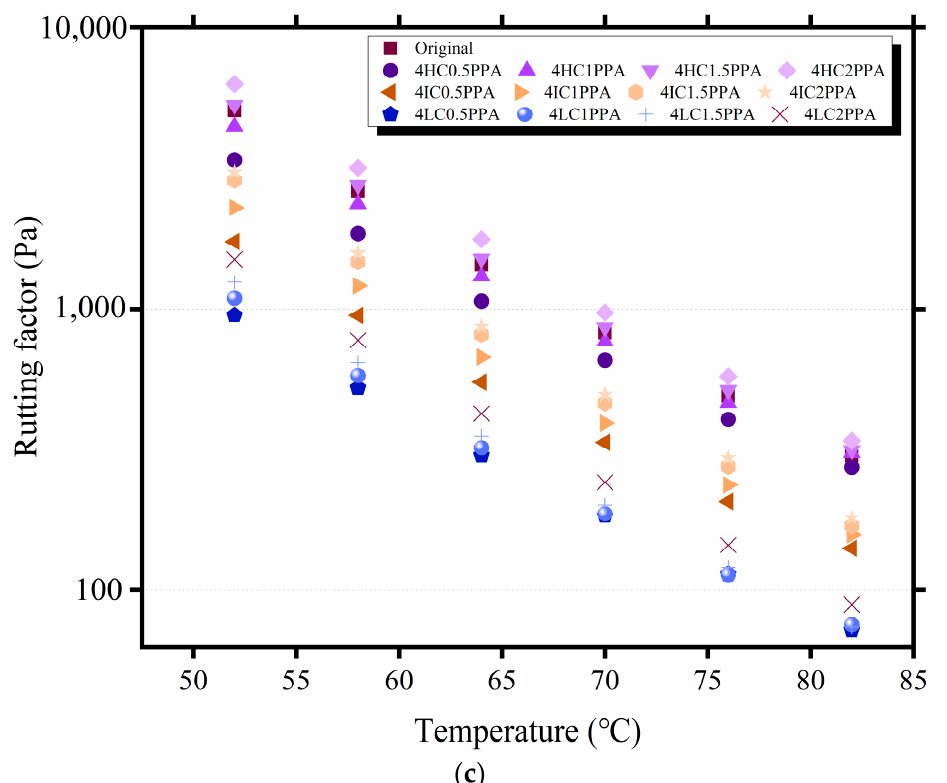
Figure 6. The temperature sweep results of modified bitumen. ( a ) Phase angle of modified bitumen. ( b ) Complex module of modified bitumen. ( c ) Rutting factor of modified bitumen.